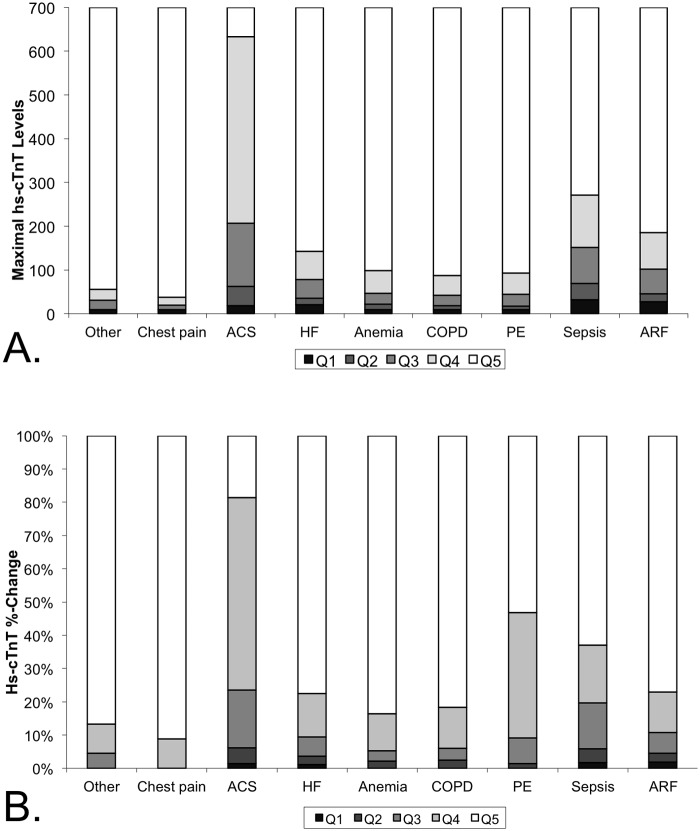
Quintiles of hs-cTnT levels and dynamics by acute diagnosis.Segmentation of high sensitivity troponin levels (A) and dynamic changes (B) to quintiles per discharge diagnosis show that most patients admitted with conditions other than chest pain had high sensitivity troponin levels above the 99th percentile (A) and are likely to have high sensitivity troponin dynamic changes (B).